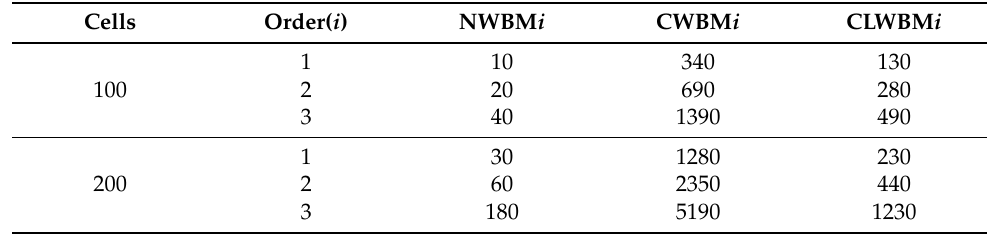
Table 7. Test 2.1. Computational cost (milliseconds). t = 5 s.